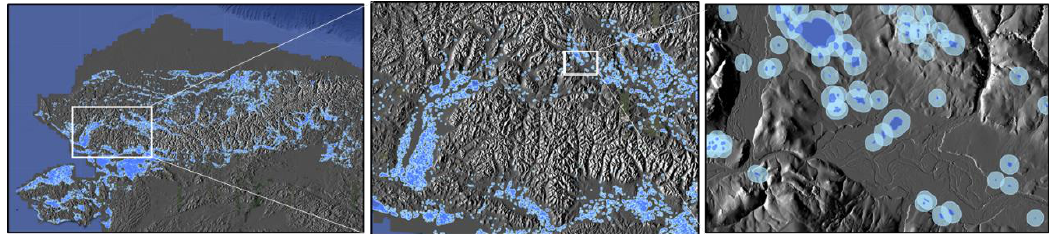
Remote Sens. 2021 , 13 , 852 Figure A1. Lake-specific 500 m buffers used with the Arctic DEM to compute lake settlement.